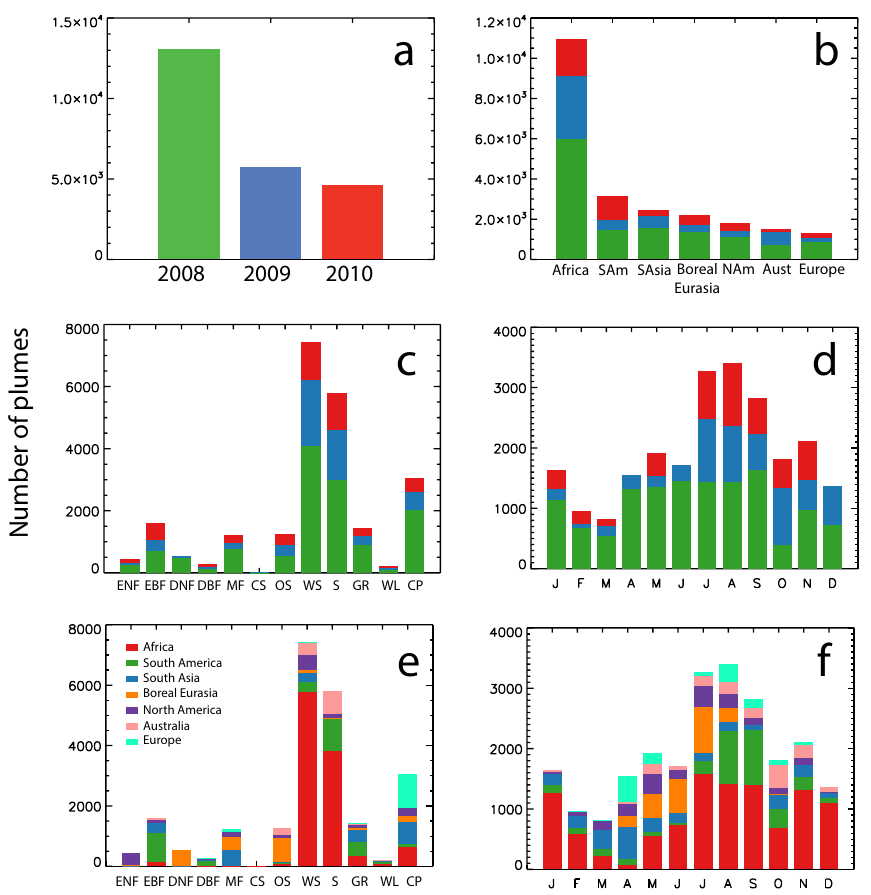
Figure 7. Summary of the MISR plume-height database stratified by ( a ) year, ( b ) region and year, ( c ) biome and year, ( d ) month and year, ( e ) biome and region, and ( f ) month and region. The 12 biomes included in this dataset are listed at the end of Section 2.1, and illustrated in Figure